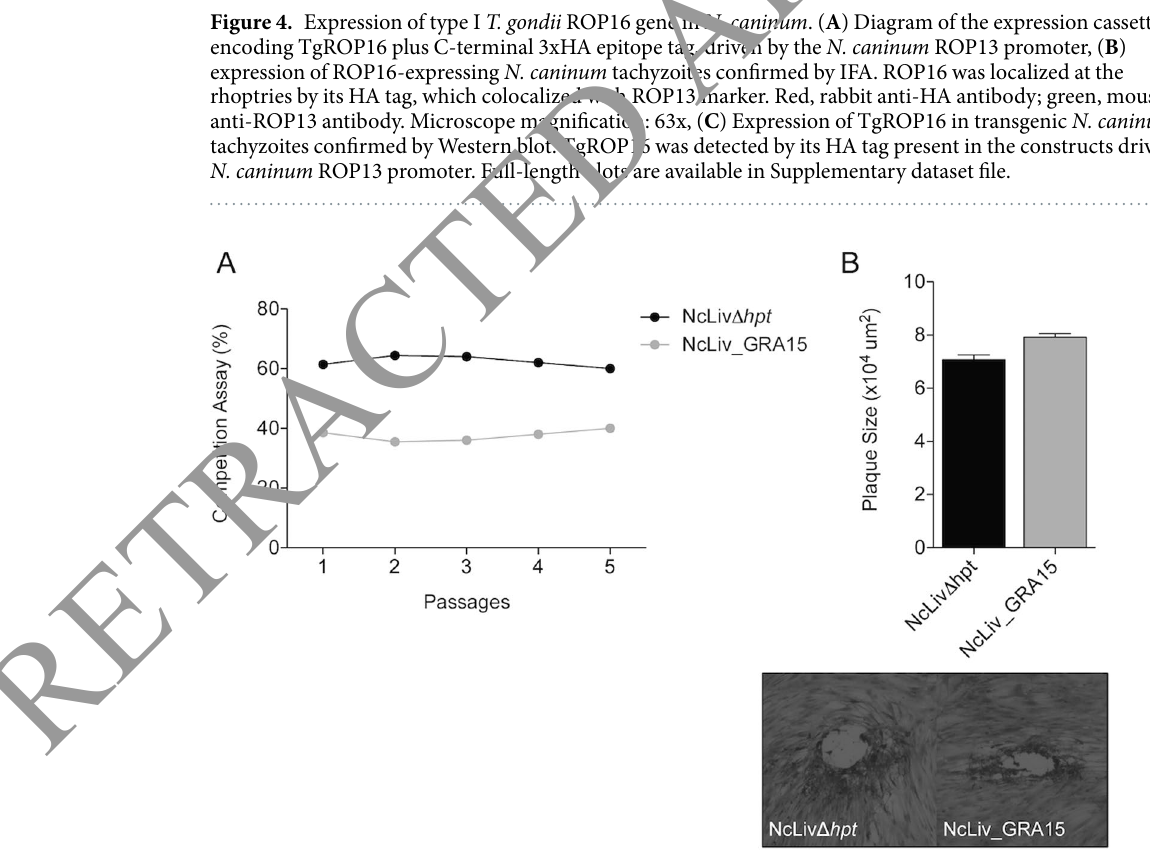
Figure 5. GRA15 expression in N. caninum does not compromise parasite fitness. ( A ) Growth competition assay of parental (NcLiv Δ hpt ) and NcLiv_GRA15 strains, co-cultured for 6 passages (50%/50% proportion), ( B ) plaque formation of parental (NcLiv Δ hpt ) and NcLiv_GRA15 strains, based on multiple lytic cycles. The area of each plaque was determined at 8 days post infection. Values are representative of two independent experiments indicating mean ± SEM of plaque size ( * P < 0.05; Student’s